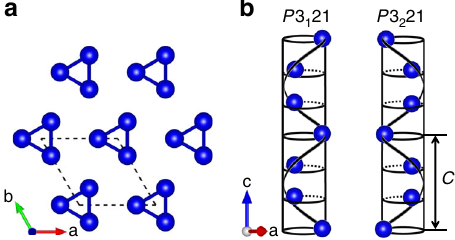
Fig. 1 Crystal structure of Te. a The structure consists of helical Te chains packed in a hexagonal array running along [001] direction. b Helical chains of Te atoms run in different manners for two enantiomorphic